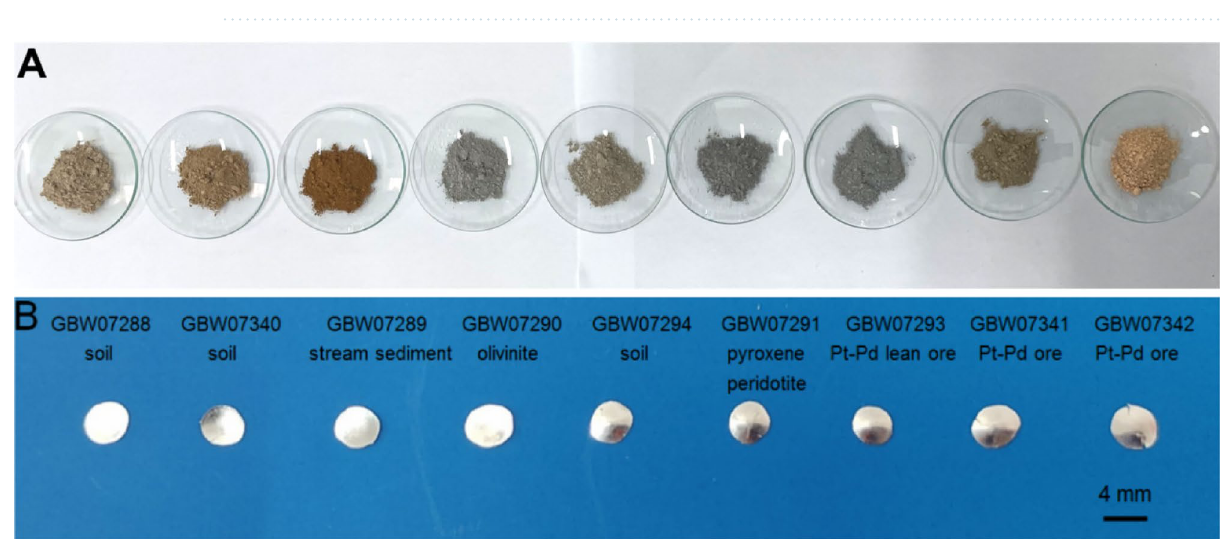
Figure 2. The effect of annealing on signal stability of 105 Pd and 195 Pt. Solid line and dotted line were the average and standard deviation after annealing.